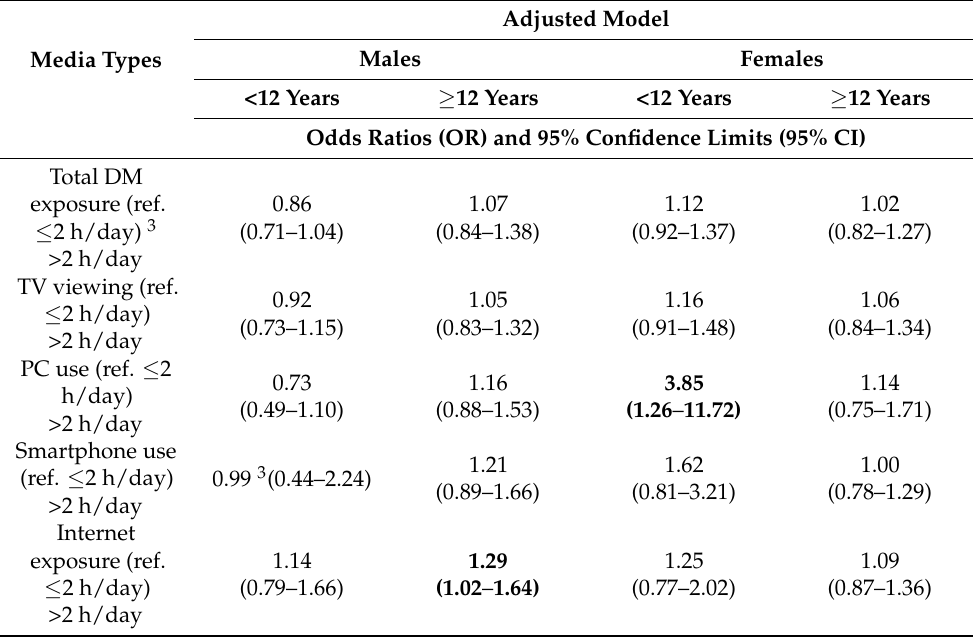
Table 6. Association of media use with salty taste preference in European children and adolescents 1,2